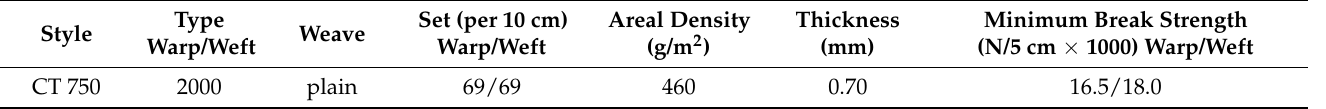
Table 1. Properties of Twaron CT 750 aramid fabric [34].